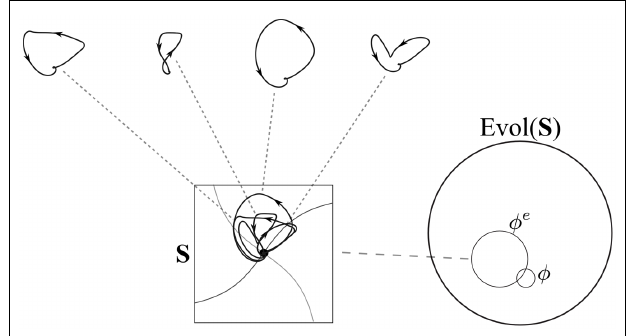
FIGURE 2 | Open phase portrait for the network whose closed phase portrait is shown in Figure 1, when it is embedded in a simple environment e . Like the closed phase portrait φ , the open phase portrait φ e corresponds to a subset of Evol( S ).